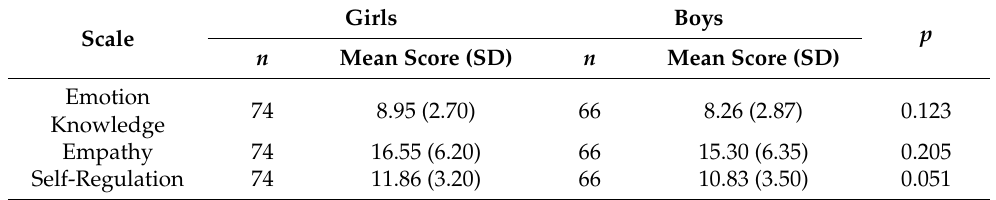
Table 2. Results of the distribution of the EMK screening scores among girls and boys.